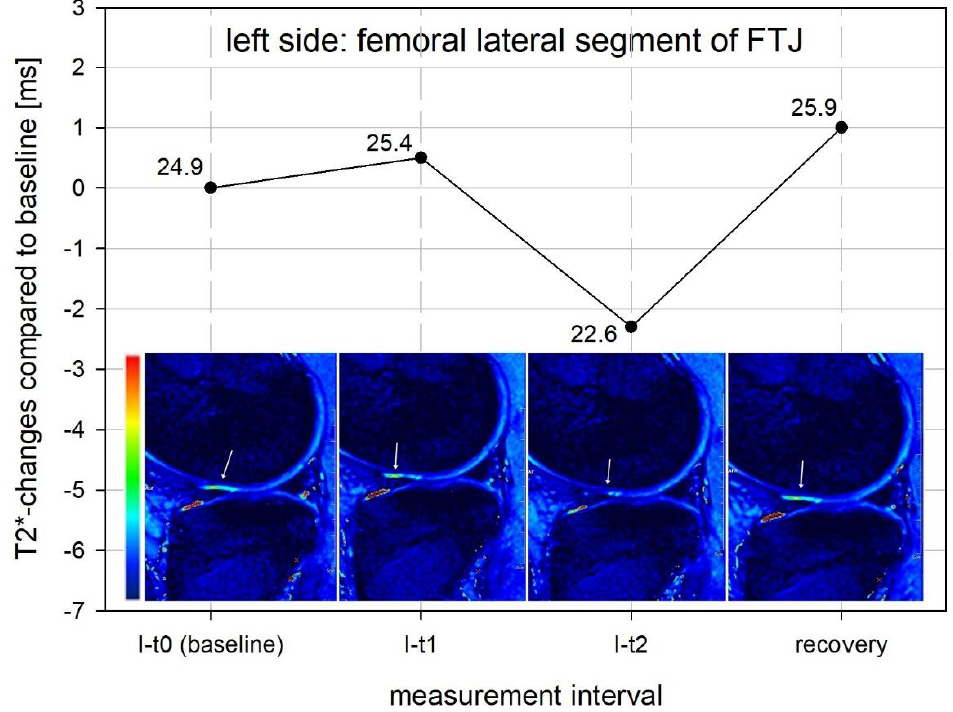
Figure 3. Color-Coded Mapping of T2*-Signaling in Comparison: decrease in green color signal indicating T2* decrease at I-t2, and renewed T2 increase at the recovery measurement corresponding to the green color signal increase.